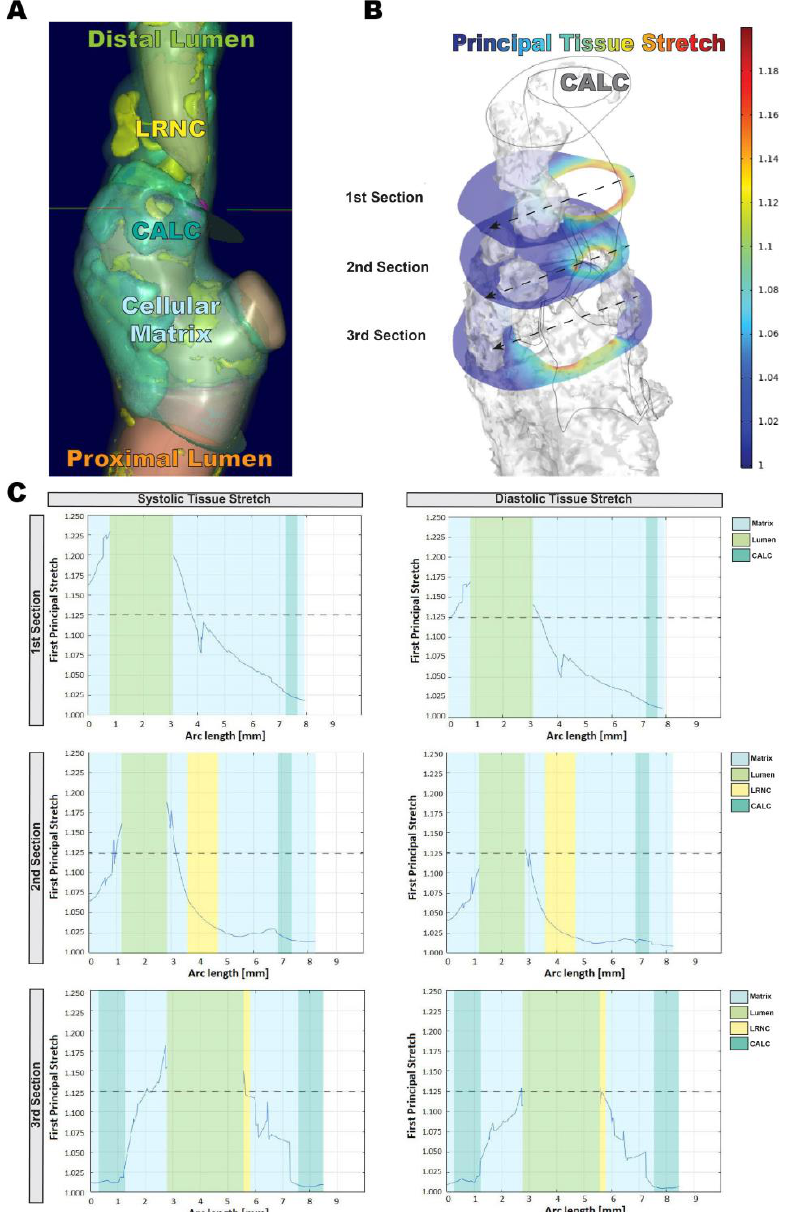
Figure 1. In silico modeling workflow and identification of load bearing capacities by carotid plaque macro-calcification. ( A ) Tissue composition of human carotid plaques was rendered and annotated using the ElucidVivo® (version A.2 Oct 8 2019, Elucid Bioimaging Inc., Boston, MA, USA) CTA image analysis software. ( B ) FEM analysis was conducted using COMSOL Multiphysics 5.6 (COM- SOL Inc., Burlington, MA, USA) to calculate spatial tissue stretch within general plaque components. Illustrations show identical plaque areas for side-by-side comparison. ( C ) Principal tissue stretch was assessed on three cross-sections distal of the bifurcation in relation to the respective tissue properties of CALC, LRNC and matrix. Graphs show distribution of tissue properties and corresponding principal stretch along a center-line, crossing the vessel wall and lumen at the respective cross-section. The dotted line indicates 12.5% principal stretch. Data presented in this figure are derived from one patient and used as a representative dataset of the whole analysis n = 4. CALC—calcification (turquoise), LRNC—lipid rich necrotic core (yellow), Matrix—Cellular Matrix (light blue), Distal Lumen (light green), Proximal Lumen